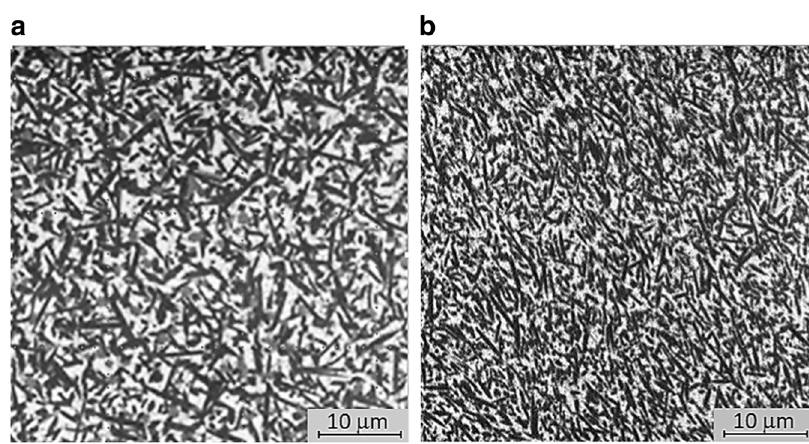
Fig. 2 SEM microstructures of polished and sandblasted surfaces of a LaMaV Press and